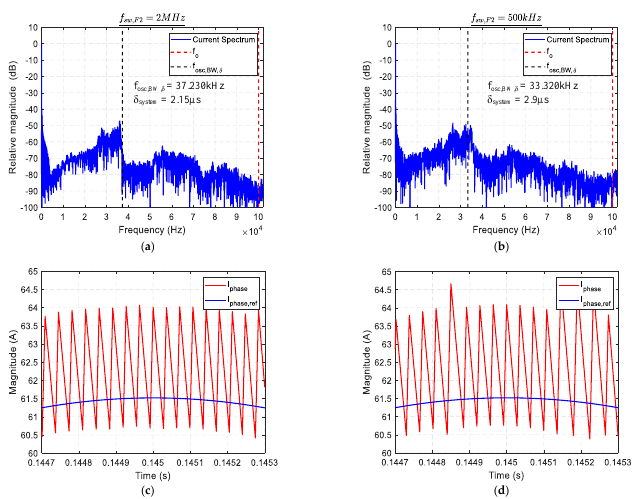
Figure 11. ( a ) Input current controlled by DPSSOCC and ( c ) its related current spectrum for a frequency 𝑓 𝑠𝑤,𝐹2 of 2 MHz. ( b ) Input current controlled by DPSSOCC and ( d ) its related current spectrum for a frequency 𝑓 𝑠𝑤,𝐹2 of 500 kHz.